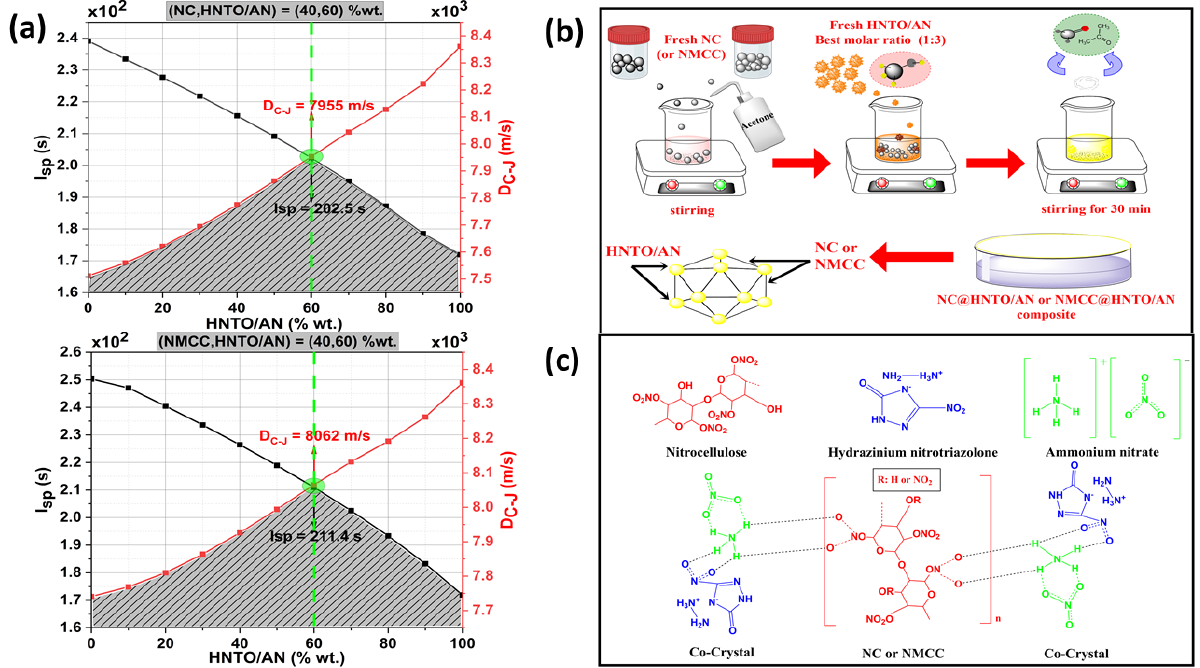
Figure 1. ( a ) Progress of detonation velocity and speci fi c impulse according to the HNTO/AN mass fraction; ( b ) preparation pathway of the composites; ( c ) chemical structures of individual com- pounds and their